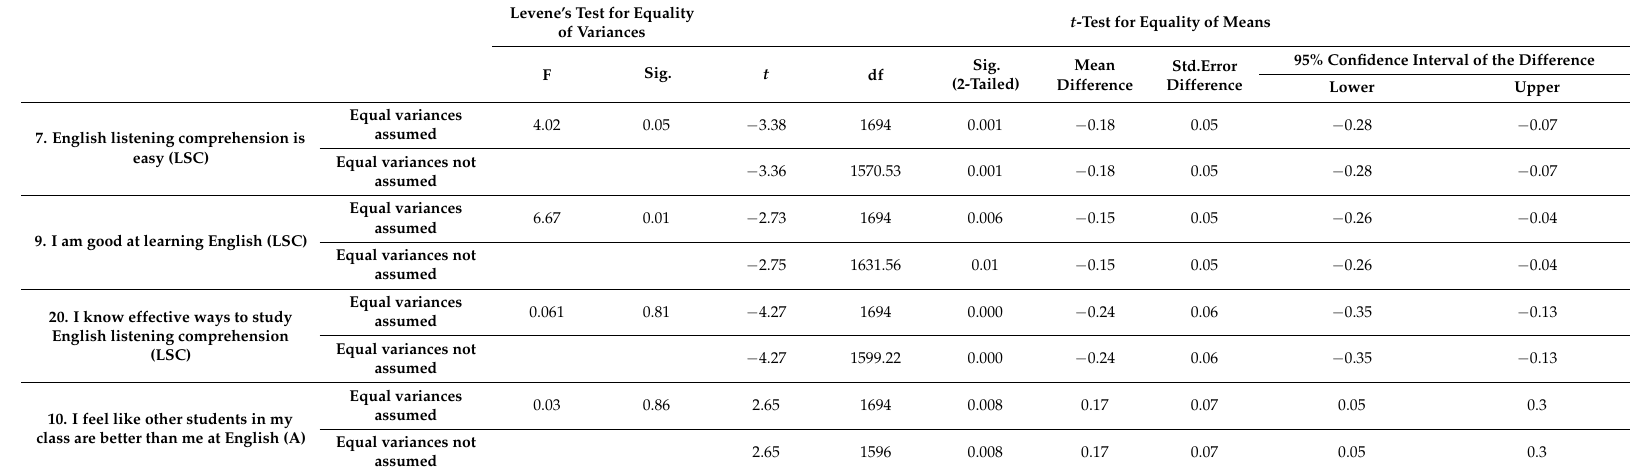
Table 1. Linguistic Self-Confidence (LSC) and Anxiety (A) items pre- and post-test. Levene’s Test for Equality of Variances t -Test for Equality of